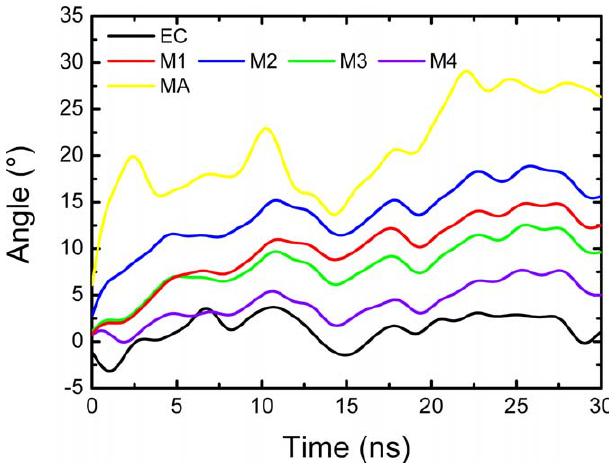
Figure 3. The Time-Dependence of the Rotational Angles of the EC domain, M1–M4 and MA helices, with Respect to Their Starting Structures